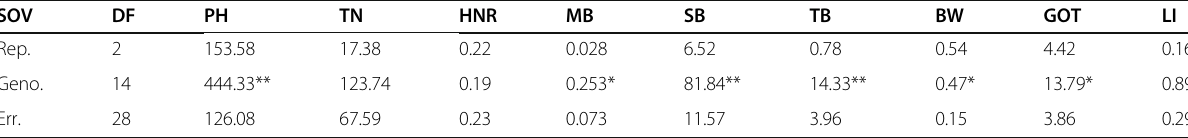
Table 2 Mean squares for yield and fiber quality related traits in G. hirsutum genotypes SOV DF PH TN HNR MB SB TB BW GOT LI Rep. Err.